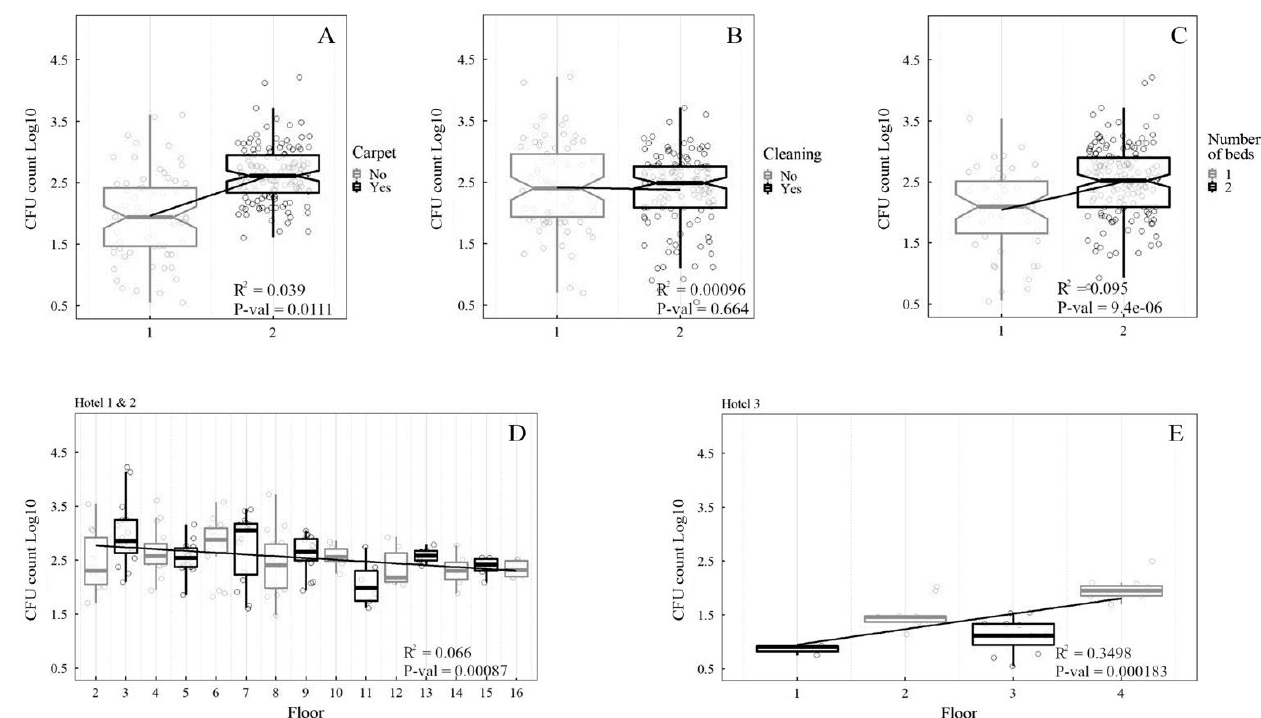
Figure 1. Statistical comparison of fungal CFU per M 3 among selected variables: rooms with carpet vs. rooms without carpet ( A ); rooms already cleaned vs. rooms not yet cleaned ( B ); rooms with one vs. two beds ( C ); floor number ( D , E ).